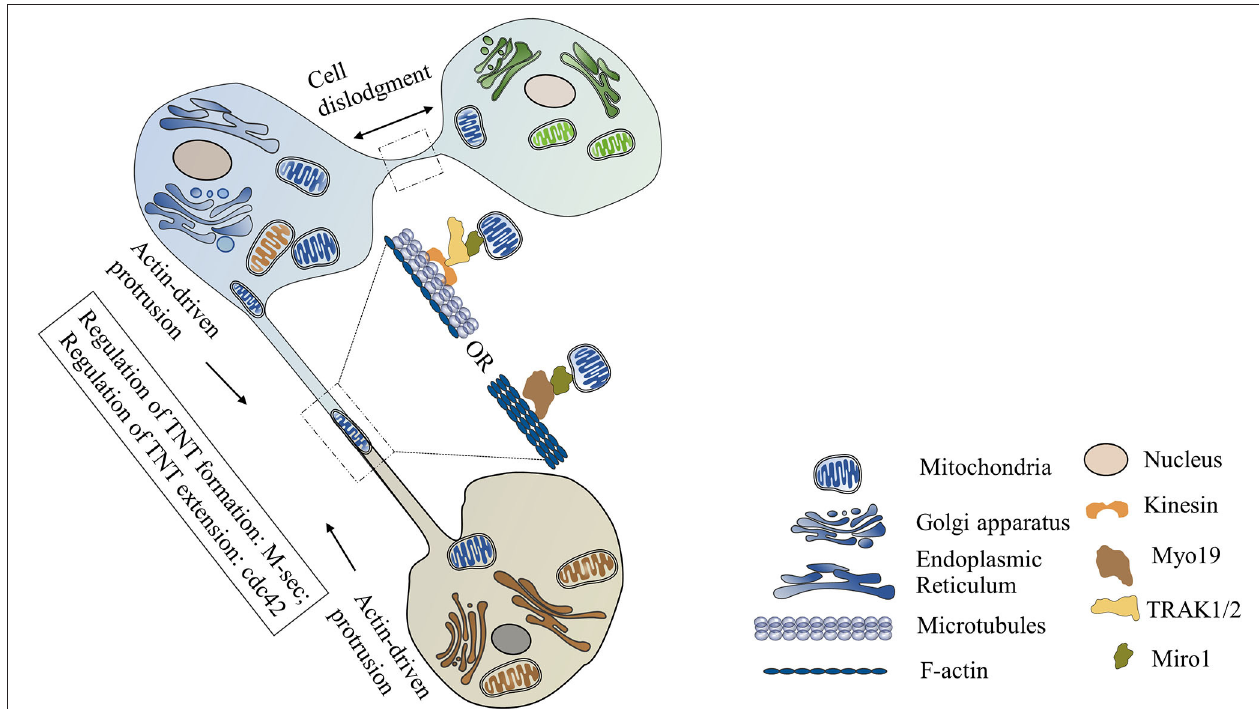
FIGURE 1 | Mitochondrial transfer via tunneling nanotubes (TNTs). TNTs are formed via cell dislodgment mechanism or actin-driven protrusion mechanism. TNTs containing only actin are small in diameter. TNTs containing both F-actin and microtubules are large in diameter. M-Sec is necessary for the formation of TNTs, while Cdc42 is required for the extension of TNTs. Mitochondrial Rho GTPase 1 (Miro1), a tail-anchored mitochondrial outer membrane protein, plays a critical role in mediating mitochondrial movement along the TNTs. After combing with the adaptor protein TRAK1/2, Miro1 can recruit motor protein kinesin and initiate microtubule-based mitochondrial movement. Miro1 can also mediate actin-based mitochondrial transport via binding with motor protein